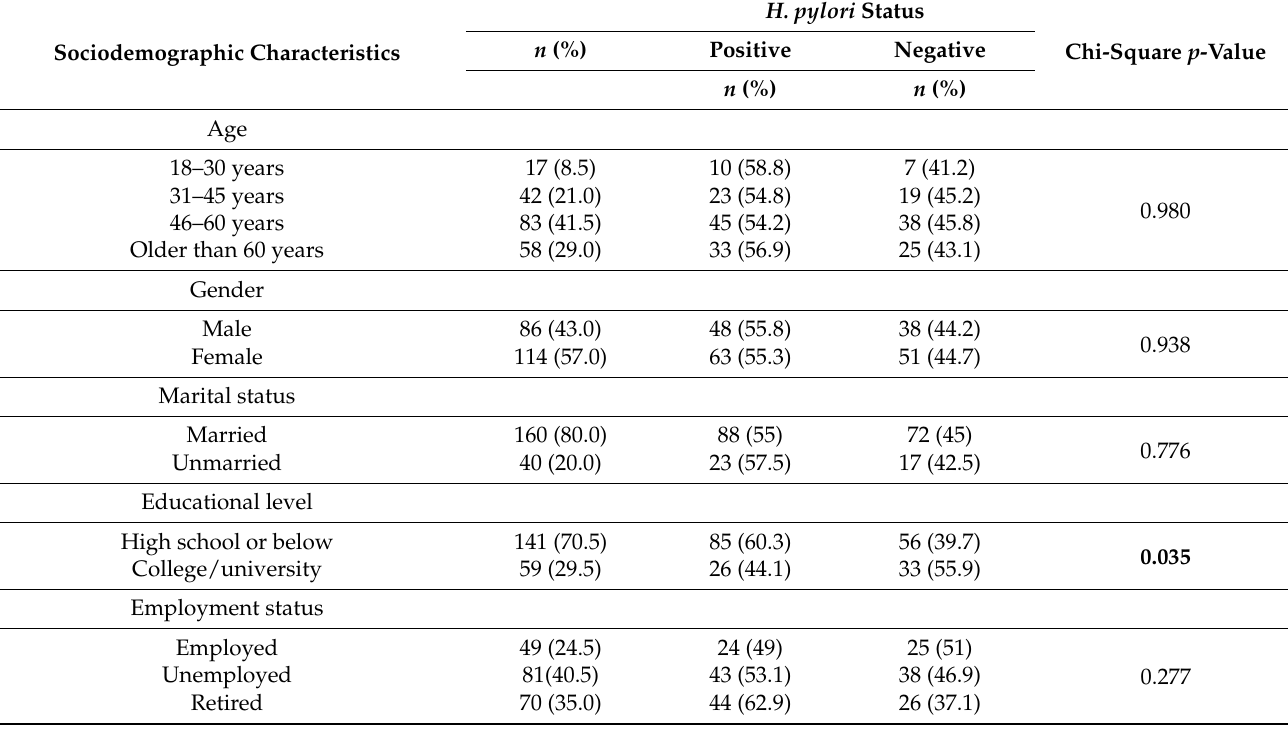
Table 1. Sociodemographic characteristics and their association with H. pylori status among the study